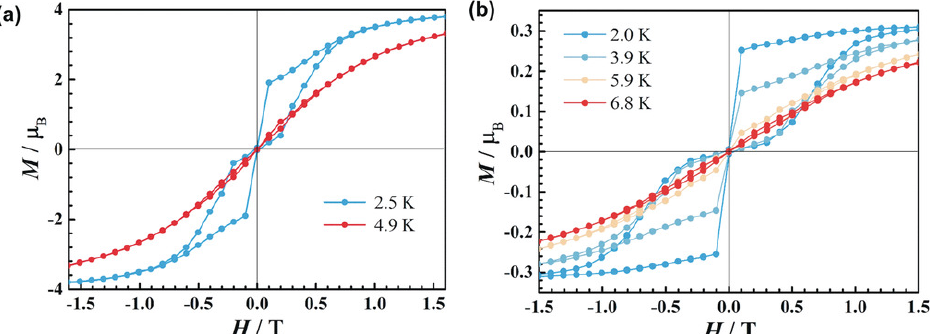
Figure 2. Hysteresis loops, measured at different temperatures in the systems ( a ) 1Dy; ( b ) 3Dy. Reprinted from [54], copyright 2020, with permission from Wiley.